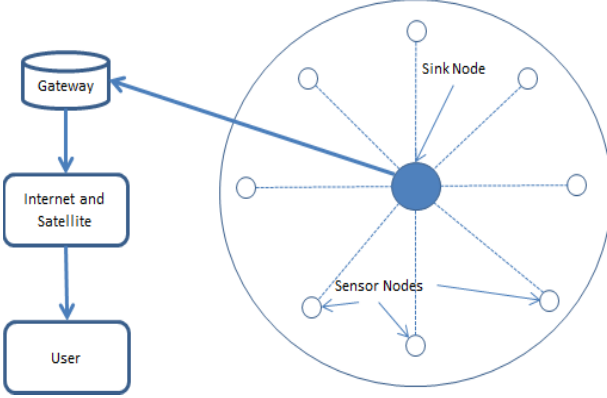
Figure 1. Traditional architecture of WSN [6] Cluster-based WSN architecture